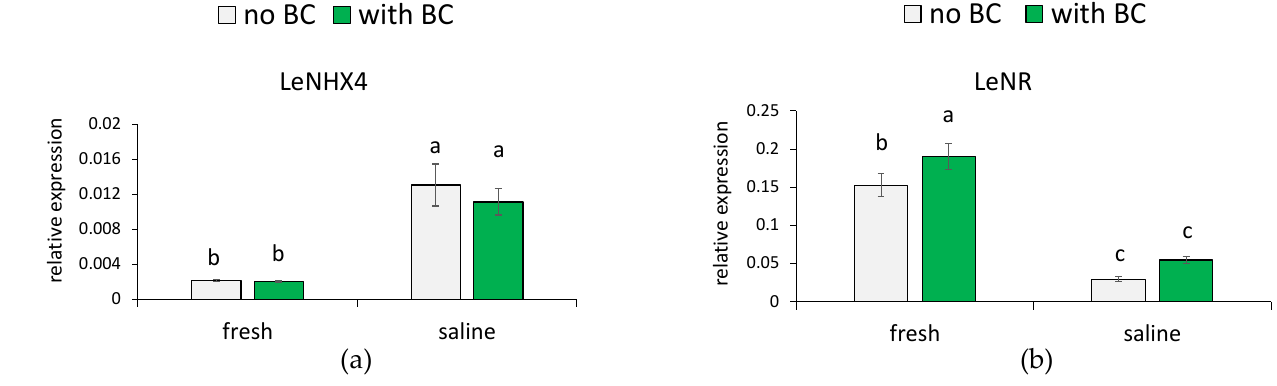
Figure 5. Alternation in transcripts accumulation for ( a ) LeNHX4 (encodes Na + /H + antiporter), and ( b ) LeNR (encodes nitrate reductase) in tomato leaves under saline irrigation regime in the absence (no BC) and presence of biochar (with BC). Values represented the means of three biological replications (two plants each) ± SE (n = 48, two seasons). Means with the same letters are not significantly different according to Duncan’s multiple range test (DMRT) ( p ≤ 0.05).